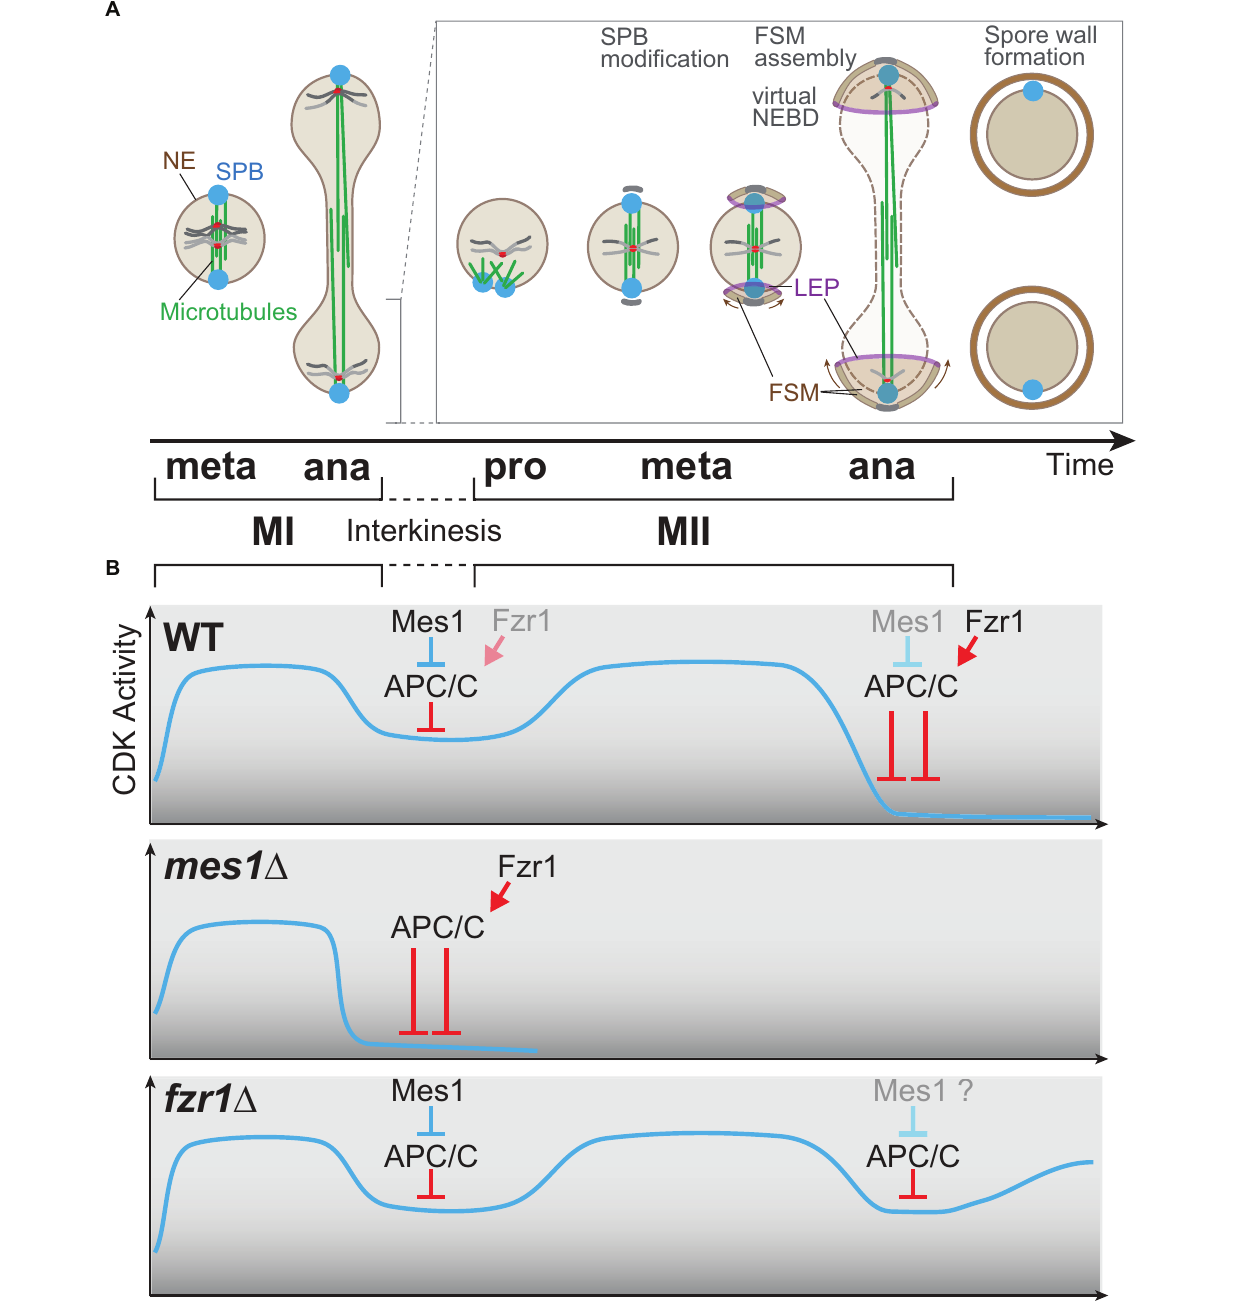
FIGURE 4 | Meiosis-specific cell cycle progression from meiosis I to meiosis II. (A) A graphical view of meiotic progression from metaphase of meiosis I (MI) to anaphase of meiosis II (MII). After anaphase I, only one of two nuclei is chosen for drawing to illustrate MII progression. In prophase II, the microtubules are nucleated from spindle pole bodies (SPBs) and form the bipolar spindle for meiosis II as in mitosis and MI. At the transition stage of metaphase to anaphase, each SPB is modified, and the globular forespore membrane (FSM) begins to grow to surround the nucleus. The leading edge of the FSM opening is decorated by leading edge proteins. During anaphase II, the barrier function of the nuclear envelope is invalidated, which is an incident called virtual nuclear envelope breakdown. After completion of MII, the rigid spore wall is assembled. (B) The kinetics of the CDK activity during meiosis. The horizontal axis (time) is shared with the time scale in (A) . In wild-type cells (top), the CDK activity elevates until metaphase I and drops at anaphase I onset, which is triggered by APC/C. The APC/C inhibitor Mes1 modulates the activity of APC/C to a moderate level so that cells can enter anaphase I and to restart meiosis II, which requires re-accumulation of the CDK activity. In mes1 (cid:49) cells (middle), Fzr1, an APC/C coactivator, is prematurely activated to fully activate APC/C, and the cells cannot enter meiosis II, and terminates meiosis early instead. In fzr1 (cid:49) cells (bottom), meiosis I proceeds almost normally, but CDK repression after anaphase II onset is not sufficient as APC/C cannot be fully activated in the absence of Fzr1. The cells then start the aberrant third division albeit incomplete.